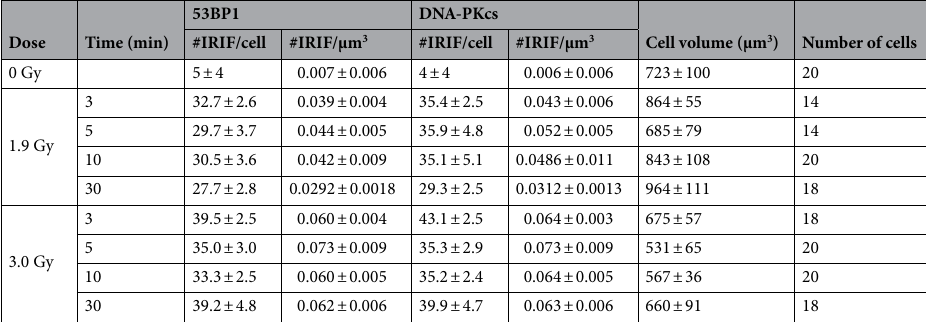
Table 1. IRIF numbers, cell volume and analyzed number of cells for 1.9 Gy and 3.0 Gy of gamma irradiation for all time points. Uncertainties represent the standard error of the mean.